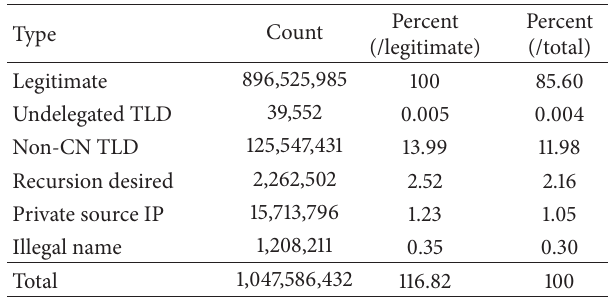
Table 1: CN Malformed query classification.